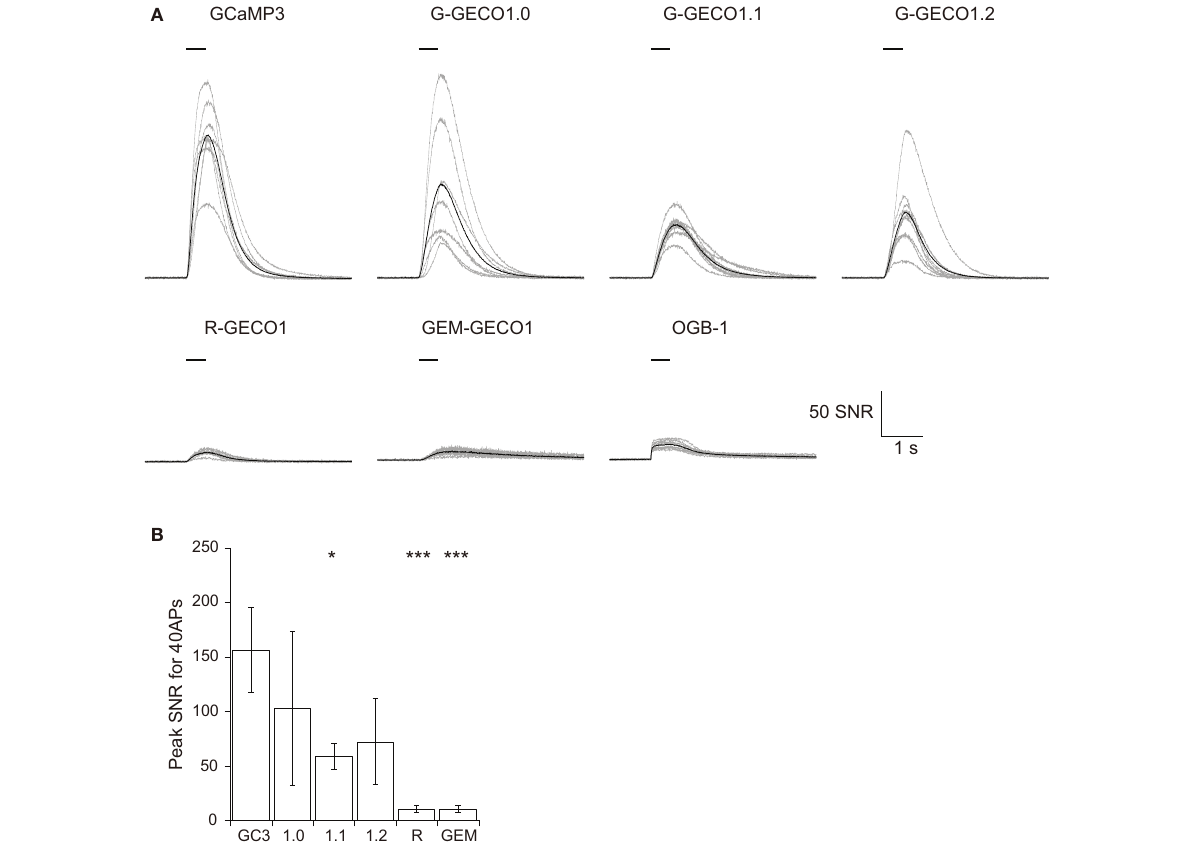
for G-GECO1.1, G-GECO1.2 and GEM-GECO1). (B) The mean peak SNR for 40APs evoked at 83Hz. Significant difference in Dunn’s post-hoc test